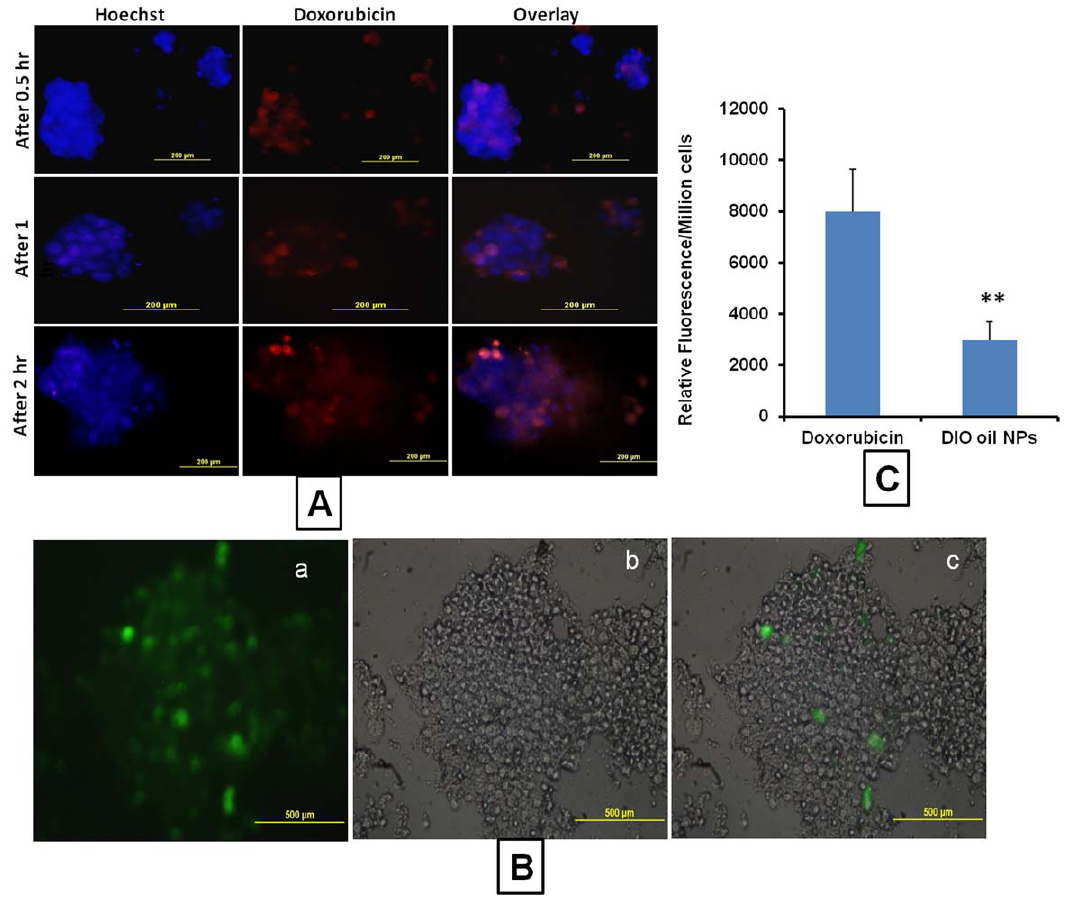
Figure 6. Drug and nanoparticles uptake by spheroids. A) Representative images of Doxorubicin uptake in H1650 parental cell spheroids grown in 3D alginate scaffold system Uptake Images were taken at 0.5, 1 and 2 h time points, B) Representative Images of the nanoparticle uptake by H1650 parental cell spheroids. DIO oil was encapsulated in NLC and incubated with the spheroids for 2 hours, a) Fluorescent image, b) DIC image and c) merged image. The fluorescent images clearly indicates the nanoparticles uptake into spheroids, C) Relative fluorescence intensities of free Doxorubicin uptake and DIO oil loaded NLC nanoparticles into 3D spheroids. Each data point is represented as mean 6 sem (n=3). **P , 0.01 Vs Doxorubicin group.